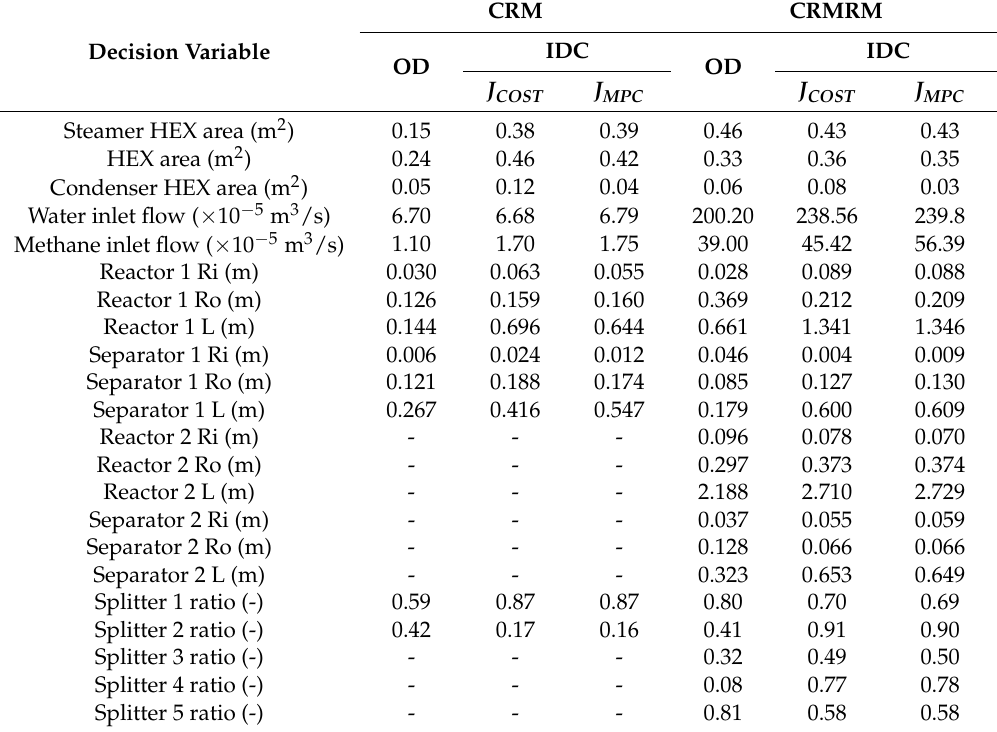
Table 4. Decision variables for the CRM and CRMRM flowsheet configurations. Comparison between multi-objective optimization results and integrated design and control